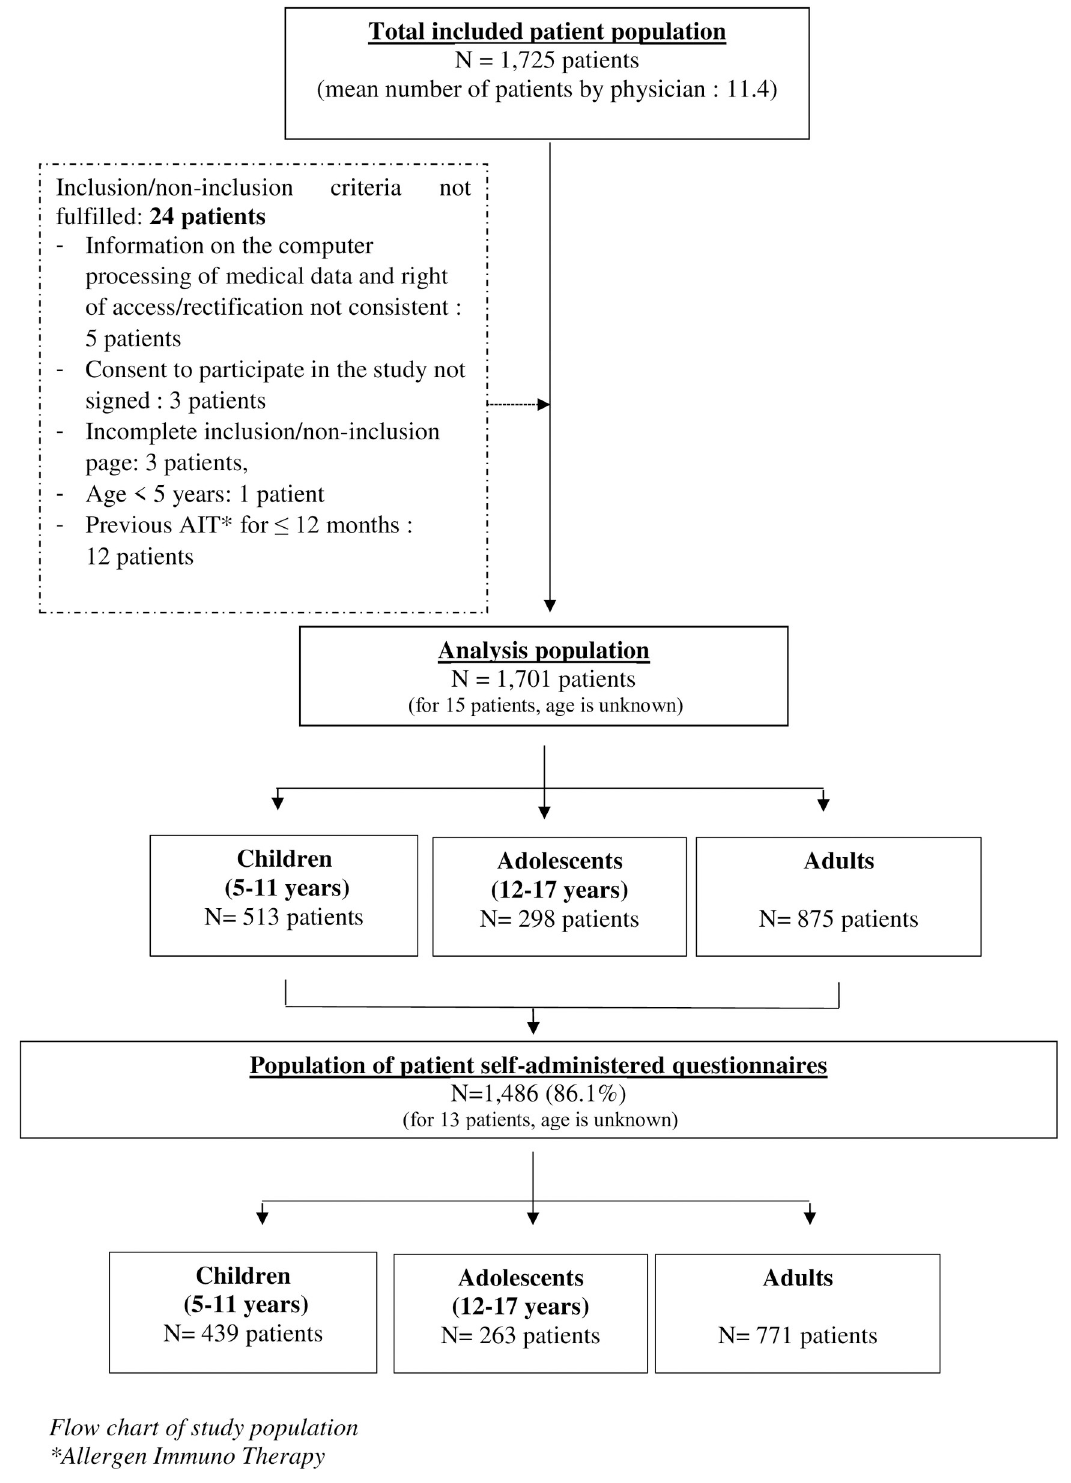
Fig 1. Flow chart of study population.